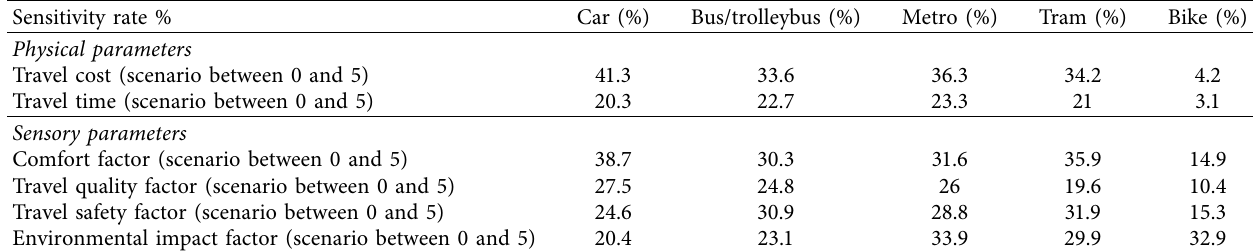
Table 10: Comparisons between the parameters of the mode choice based on various